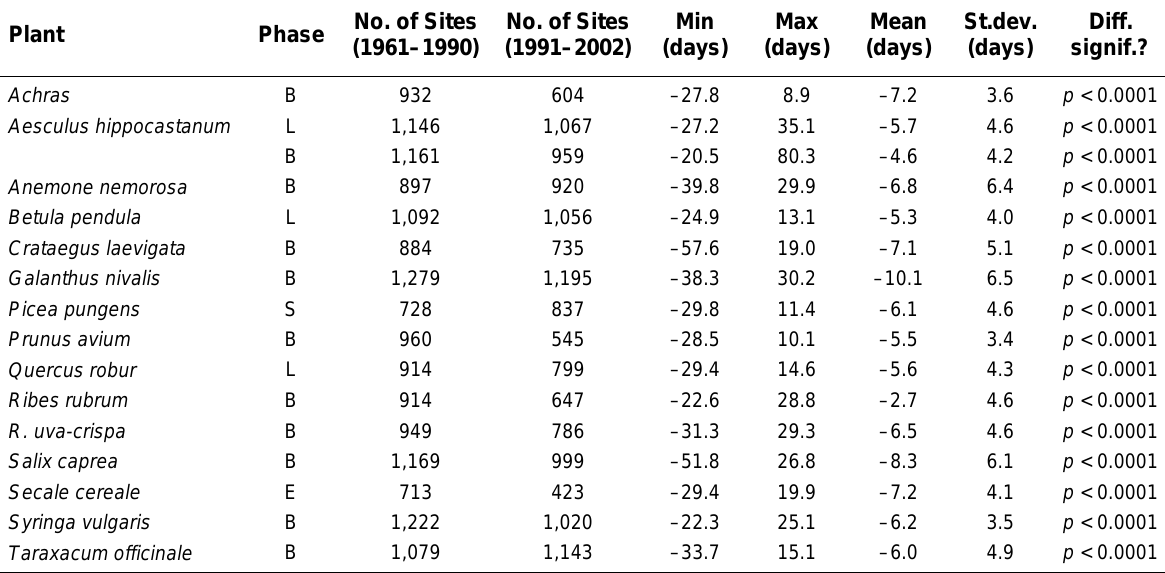
Statistical Analyses of the Variations in the Start of the Spring Phases of 15 Plant Species